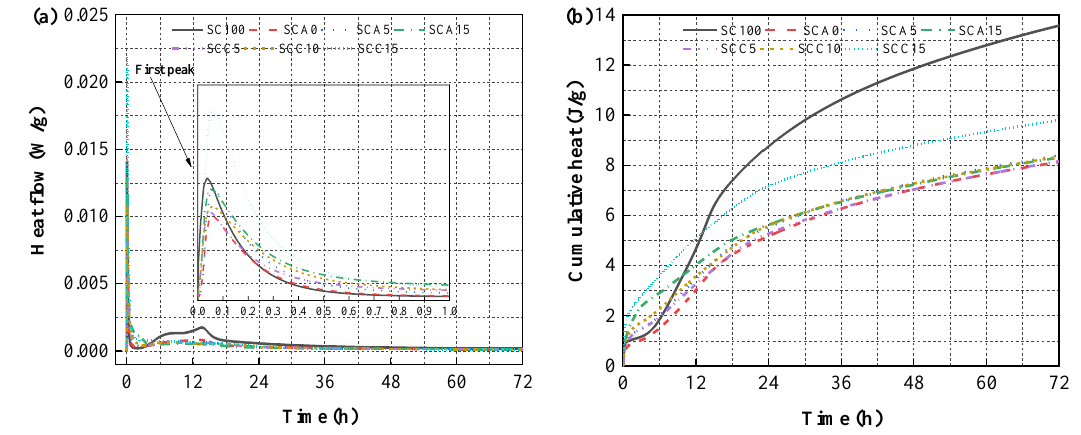
Figure 9. The heat flow of binder pastes: ( a ) first exothermic peak, and ( b ) cumulative heat.